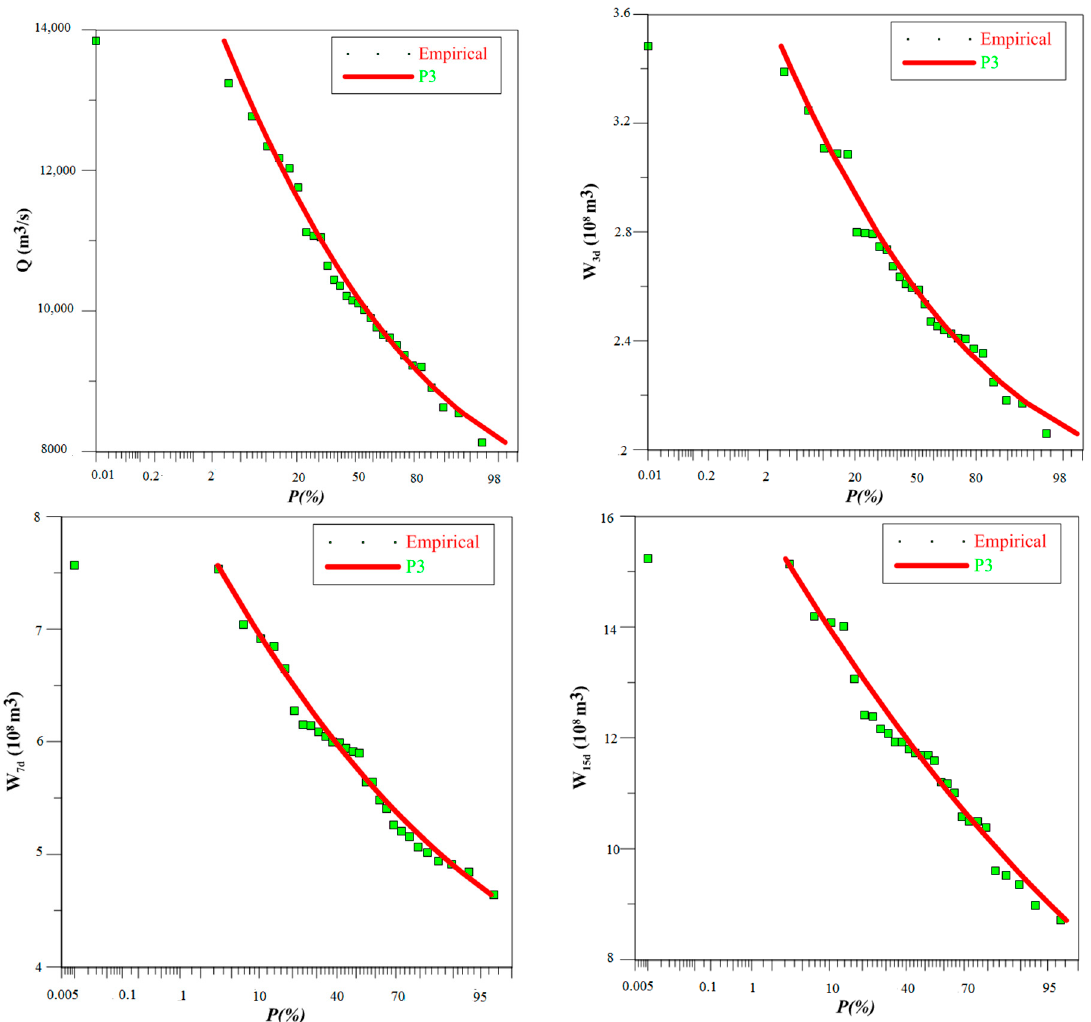
Figure 5. The fit of P3 frequency curves to the empirical record of flood peak and volume.